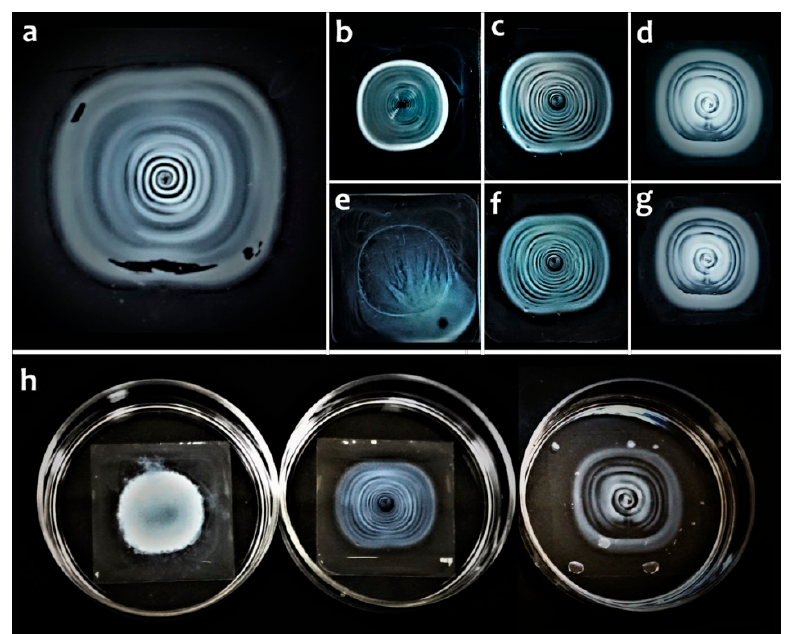
Figure 8. Concentric structures made from 1% suspensions ( w / v ) of halloysite-Mg-DNA ( a , d , g ), halloysite-PSS ( b , e ), halloysite-PSS-Mg-DNA ( c , f ) before ( a – d ) and after immersion in water ( h ) and drying ( e – g ).